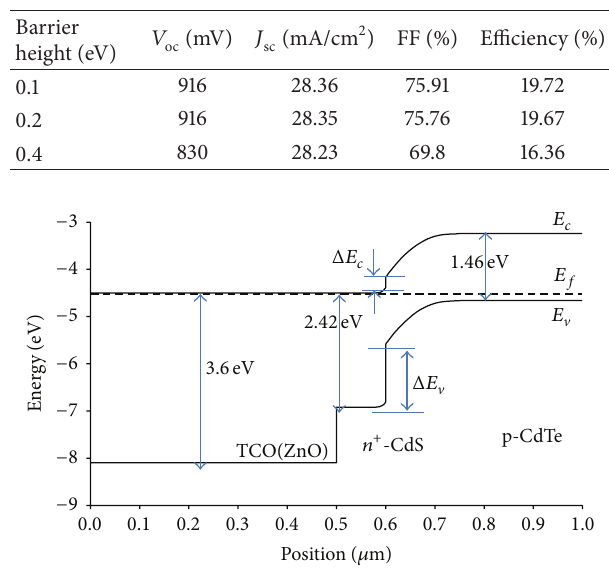
Figure 2: Band diagram of TCO/CdS/CdTe cell without electron reflector layer.